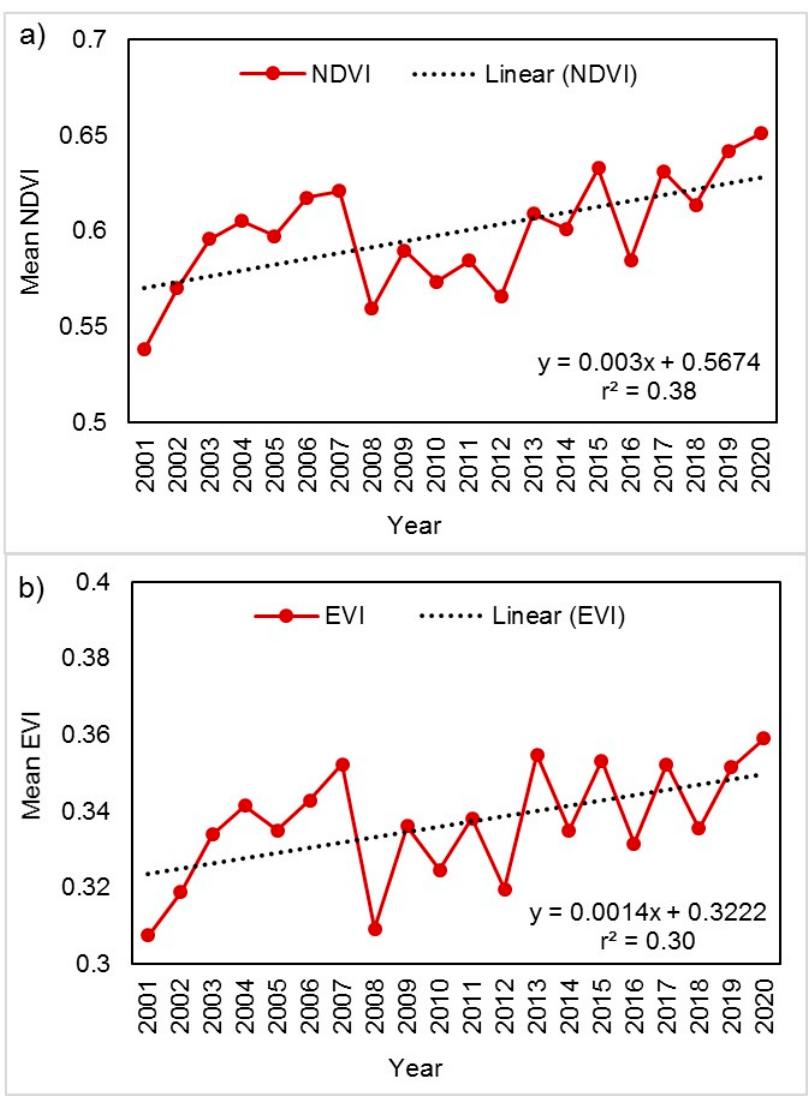
Figure 4. Inter-annual variability of ( a ) NDVI and ( b ) EVI over the twenty-year period (2001–2020) Figure 9 for the UKR